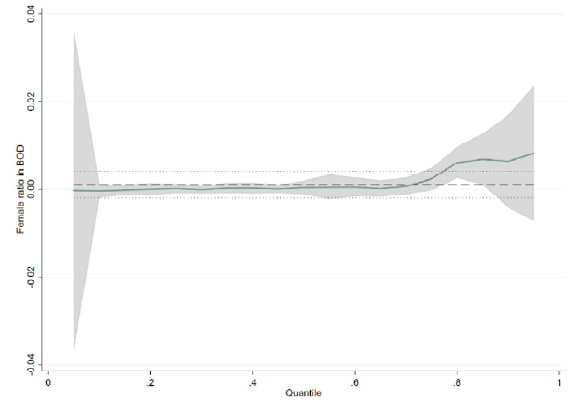
Figure 7. The quartile impact of female ratio on EPS.